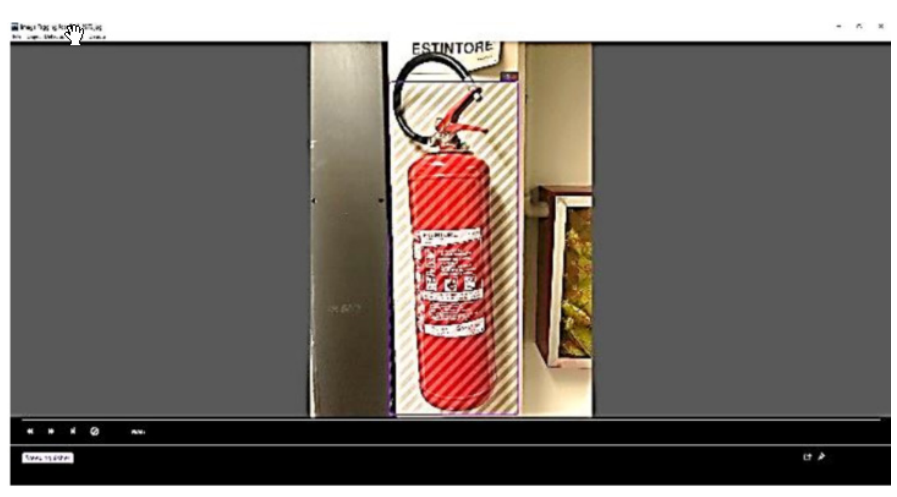
Figure 8. Image captured by the Hololens. A bounding box is drawn to delimit the object to label [71].